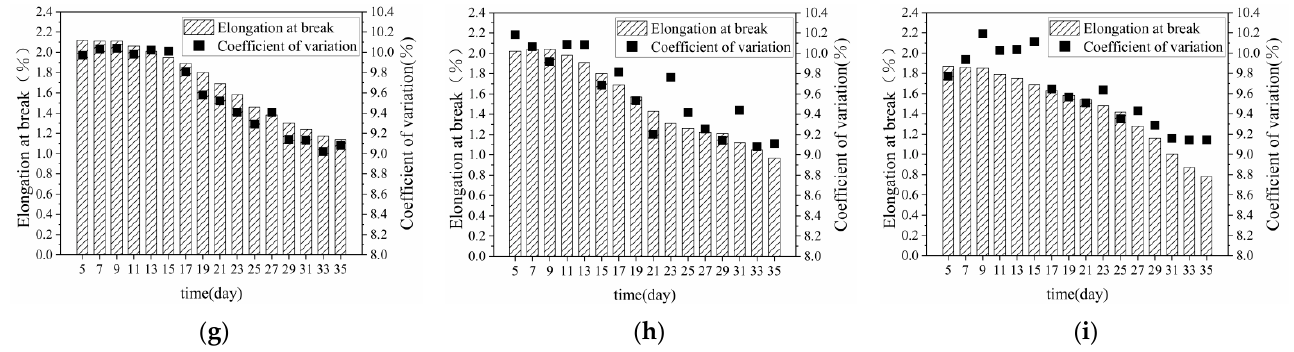
Figure 6. Breaking elongation of fibres in different parts of banana stalks ( a ) A Ⅰ ; ( b ) A Ⅱ ; ( c ) A Ⅲ ; ( d ) B Ⅰ ; ( e ) B Ⅱ ; ( f ) B Ⅲ ; ( g ) C Ⅰ ; ( h ) C Ⅱ ; ( i ) C Ⅲ .